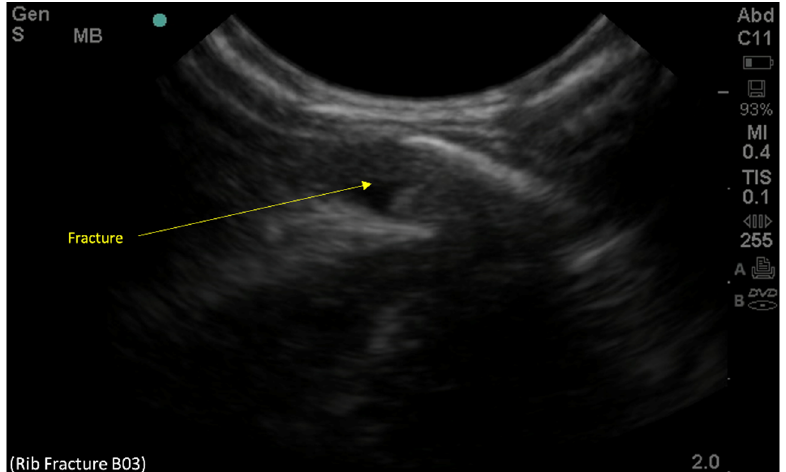
Figure 3. Point-of-care-ultrasound of the left posterior third rib on the longitudinal view demonstrating cortical disruption and suggesting a new fracture of the left posterior third rib, which was not reported in the chest radiographs.